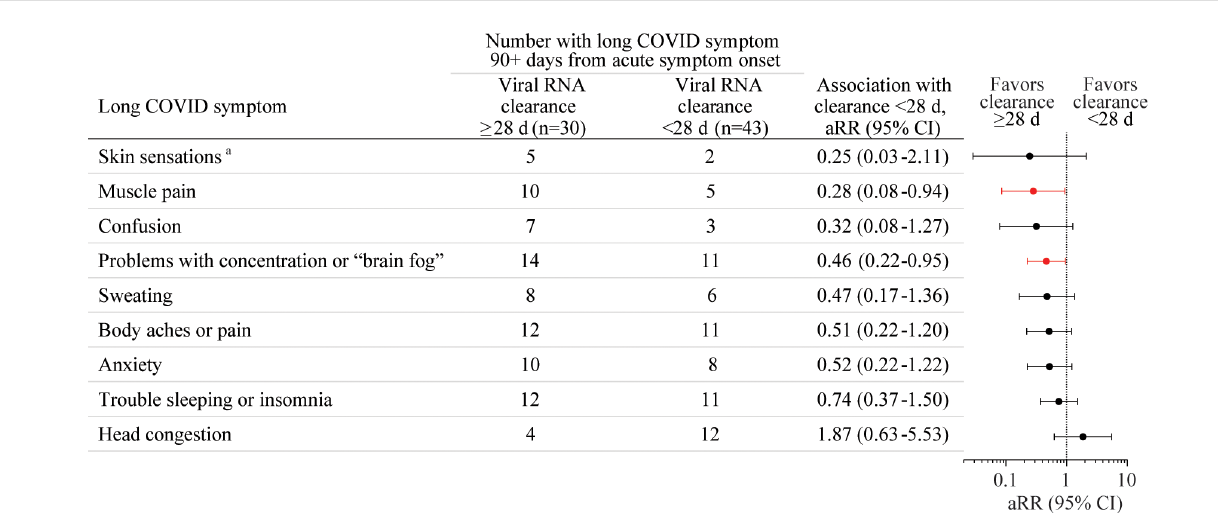
FIGURE 1 The association of the presence of each of the 49 long coronavirus disease (COVID) symptoms at 90+ days after acute COVID-19 illness onset with SARS-CoV-2 RNA clearance from the upper respiratory tract (URT, mid-turbinate nasal and/or saliva) within 28 days from acute COVID-19 onset was tested without adjustment using log-binomial regression analyses. Nine long COVID symptoms with p -values <0.2 were tested using log-binomial regression analyses with adjustment for age, sex, BMI over/under 25, and COVID vaccination status prior to acute COVID-19 (1+ vaccines vs . none), with results shown here. aRR, adjusted risk ratio, d, day. a Tingling, numbness, coldness, or other unusual sensation in the